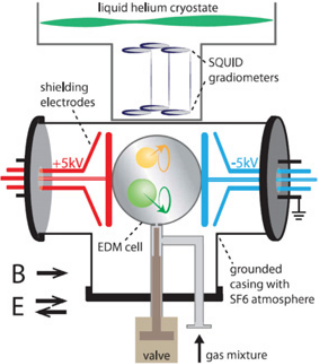
Figure 1. Inner part of the MIXed 129 Xe-EDM experiment.